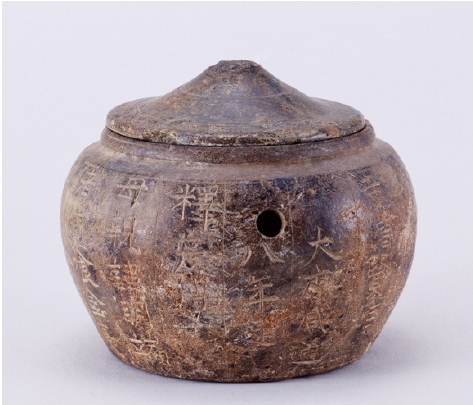
Figure 9. Sarira reliquary, Unified Silla, 867, 9.5 cm, Three-story western pagoda of Ch’uks ŏ temple, in Ponghwa, Gyeongsangbuk-do, Korea, Ky ŏ ngju National Museum, Korea [©Photograph by O Seyun, 2014].